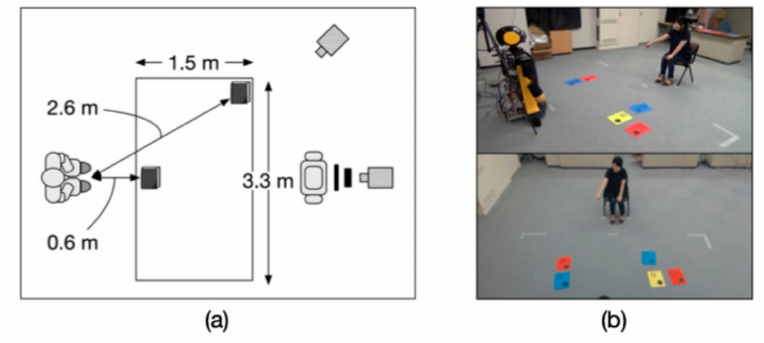
Figure 11. ( a ) Experimental environment; ( b ) example scenes in Experiment